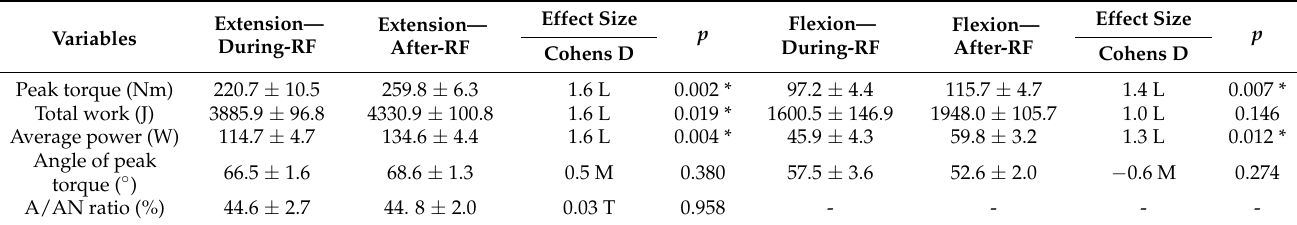
Table 1. Mean ± standard deviation values of isokinetic variables at 60 ◦ /s during (during-RF) and after Ramadan fasting (after-RF).